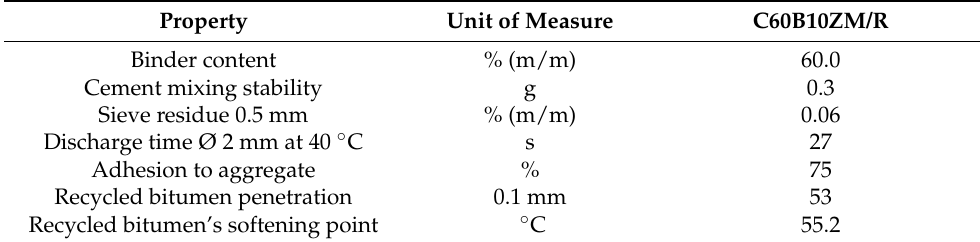
Table 5. Physical properties of the bitumen